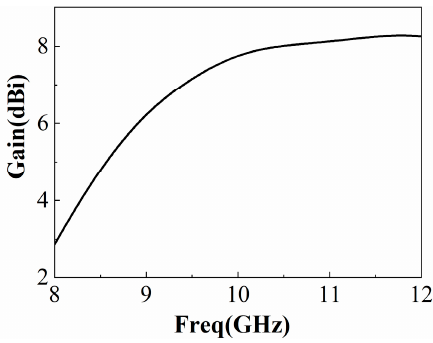
Figure 4. Reflection coefficient and gain of feed antenna.